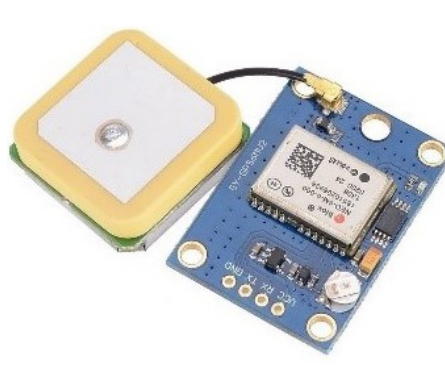
Figure 8. GY-GPS6MV2.